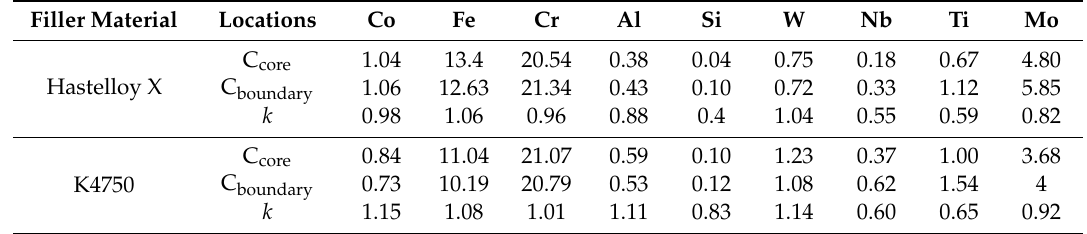
Table 4. Elements segregation coefficients of weld fusion zone with varies filler materials (wt %). Filler Material